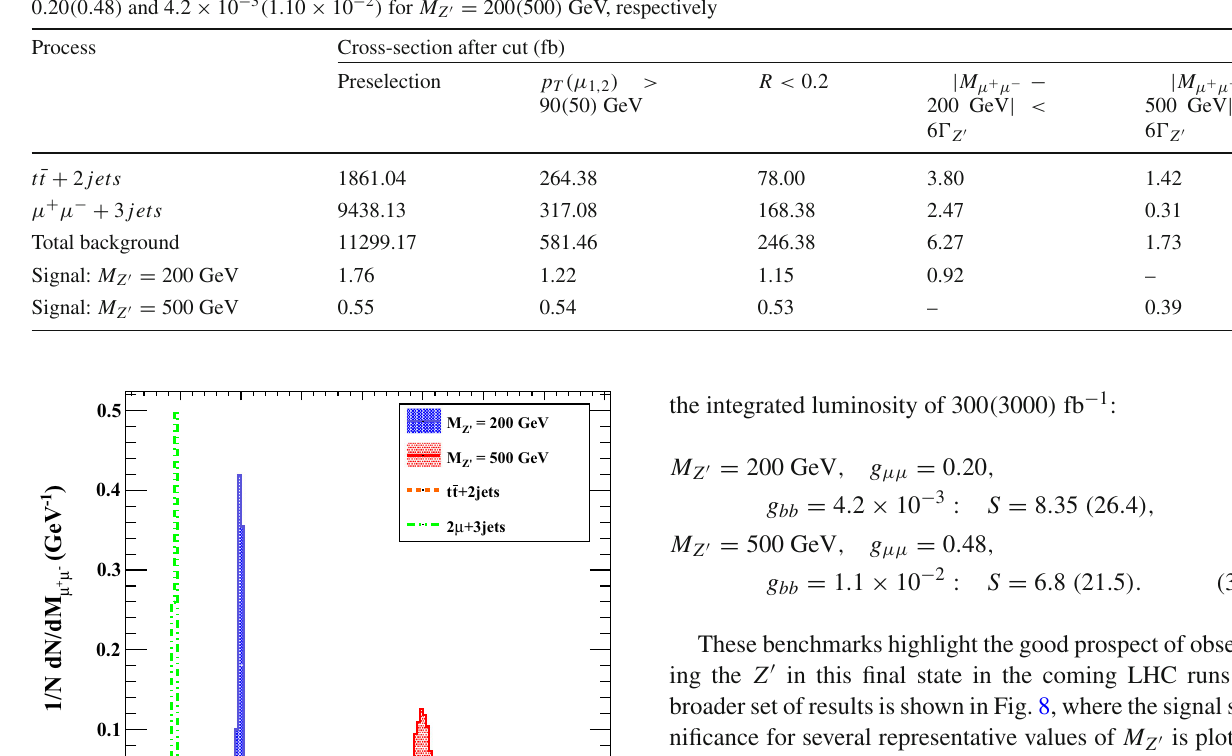
Table 2 The signal and background cross sections for the μ + μ − + 1 b ( 2 b ) process after each cut for